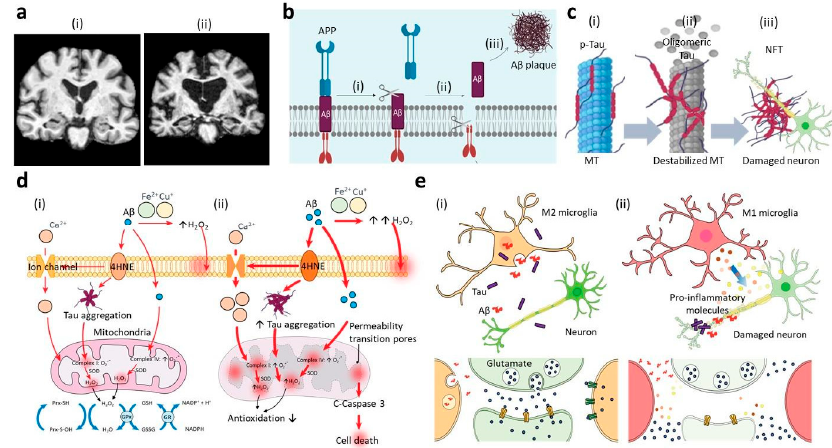
Figure 1. Summary of major signatures during Alzheimer’s disease (AD) progression. ( a ) Comparison of brain coronal sections from (i) healthy individual and (ii) AD patient by magnetic resonance imaging (MRI), confirming the significant damage in the AD patient having the reduced brain mass. Reproduced with permission [4]. Copyright 2018, Scientific Reports. ( b ) Amyloid-beta hypothesis: In early AD, the enzymatic cleavages of amyloid-beta precursor protein (APP) by (i) β -secretase followed by (ii) γ -secretase are dominant and result in the formation of A β peptides, which are hydrophobic and prone to form aggregations. (iii) In the early to intermediate stages of AD, the aggregates form into A β amyloid fibrils and plaques that further cause phosphorylation of tau, neuronal death, cell loss, and dementia, sequentially [81,84]. ( c ) Tauopathy: (i) Upon the hyperphosphorylation on the multiple sites of tau, the tau proteins are not able to bind to the microtubules (MT) resulting in the disruption of microtubule structures inside neuronal cells. (ii) They further form oligomeric tau, paired helical filament (PHF), and neurofibrillary tangle (NFT), consequently, and (iii) the accumulation of NTFs in the neurons increases the synaptic impairment and the neuronal death in the middle stage of AD [87,88]. ( d ) Oxidative stress: (i) Under normal or mild AD conditions, antioxidation mechanisms (e.g., mitochondrial redox cycles) can reduce the oxidative stress caused by A β and tau aggregations. (ii) In later stages of AD, however, the accumulation of A β and tau triggers the excessive production of oxidative stress and reduces the antioxidation mechanism of mitochondria or antioxidant enzymes, which increases the neuronal death [89,90]. ( e ) Neuroinflammation: (i) In the early stages, innate immune cells obtain phenotypes (e.g., M2 microglia, A2 astrocyte, etc.) serving neuroprotective roles, such as the removal of A β and tau aggregations and the production of anti-inflammatory cytokines, as well as neurotrophic factors. (ii) In the later AD stages, on the other hand, the population of proinflammatory immune cells (e.g., M1 microglia, A1 astrocyte, etc.) becomes dominant and increases the risk of AD by producing several neurotoxic mediators, such as oxidative sources and proinflammatory cytokines / chemokines